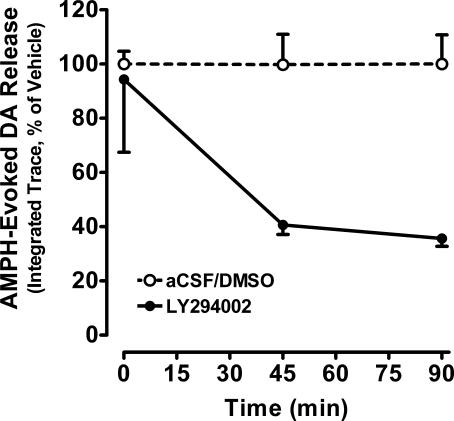
Inhibition of PI3K Decreases AMPH-Induced Striatal DA ReleaseDA concentration was determined by digital integration of in vitro–calibrated oxidative currents using HSCA recordings in the striatum. The PI3K inhibitor LY294002 or vehicle (aCSF in DMSO) was microinjected into the striatum 300 μm away from the carbon fiber electrode. AMPH (400 μM/125 nl) was then ejected 0, 45 or 90 min later. Data represent peak AMPH-induced DA release expressed as a percentage of vehicle. Main effect treatment p < 0.005, two-way ANOVA; *p < 0.05, Bonferroni post hoc (n = 3–4).